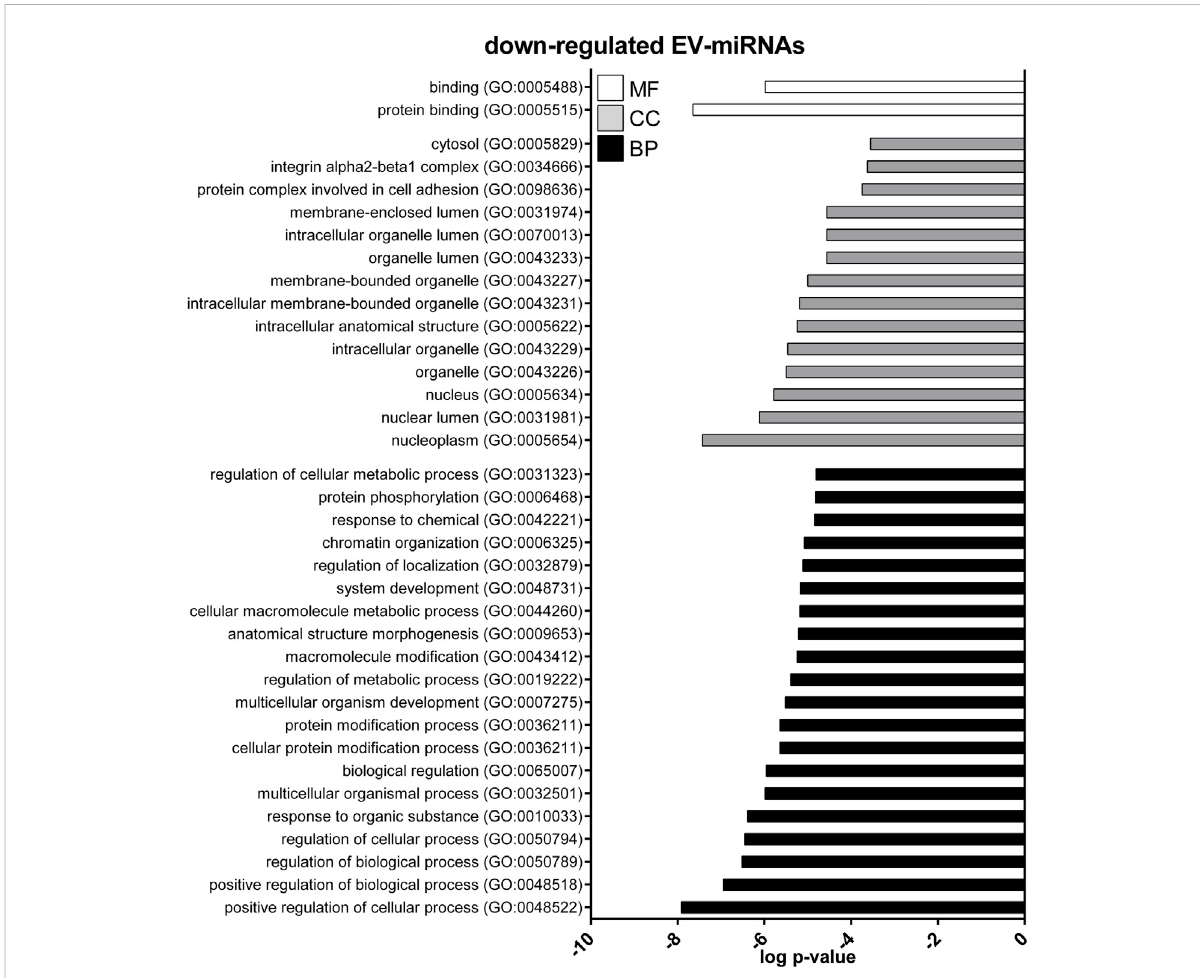
FIGURE 6 Gene ontology (GO) of predicted target genes for down-regulated EV-miRNAs. GO of 287 target genes predicted for down-regulated EV- miRNAs performed with Panther ver 17.0 (http://www.pantherdb.org/). Genes were classi fi ed based on biological processes, cellular component, andmolecularfunction.The fi rst20mostenrichedcategorieswereshown.Statisticaloverrepresentationtestsshowingthe p -valueofeachcategory are shown in Supplementary Table